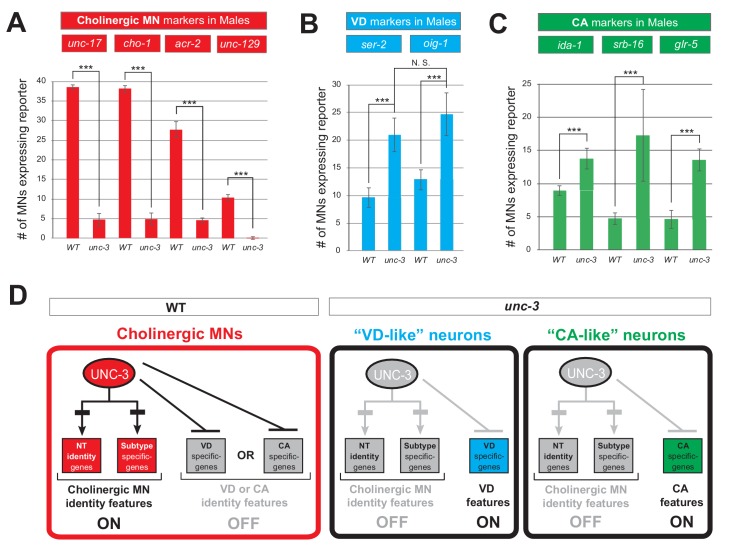
The dual role of UNC-3 in cholinergic MNs extends to both C. elegans sexes.(A) Quantification of four sex-shared cholinergic MN markers (unc-17, cho-1, acr-2, unc-129) expression in WT and unc-3 (n3435) male animals at L4. N > 13. ***p<0.001. (B) Quantification of VD marker (ser-2 and oig-1) expression in L4 stage WT and unc-3 (n3435) male animals. No significant difference was found between the number of MNs ectopically expressing each marker. N > 11. ***p<0.001. N. S: not significant. (C) Quantification of the male-specific CA markers (ida-1, srb-16 and glr-5) in young adult stage WT or unc-3 (n3435) male animals. N > 14. ***p<0.001. (D) Schematic summarizing the dual role of UNC-3 in C. elegans males.